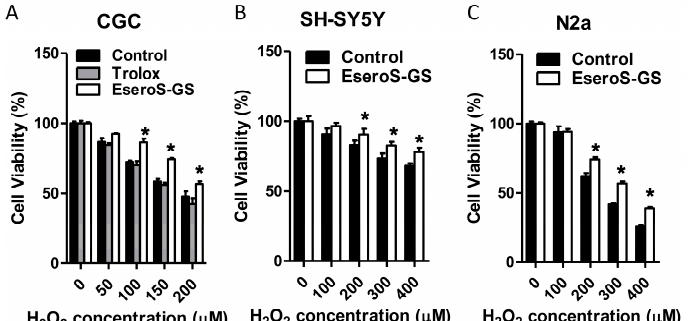
Figure 2. Protective effects of ESeroS-GS on neuronal cells. ( A ) protective effects of ESeroS-GS on cerebellar granule cells; ( B ) protective effects of ESeroS-GS on human SH-SY5Y neuroblastoma cells; ( C ) protective effects of ESeroS-GS on murine N2a neuroblastoma cells. *: p < 0.05 in comparison with control cells.